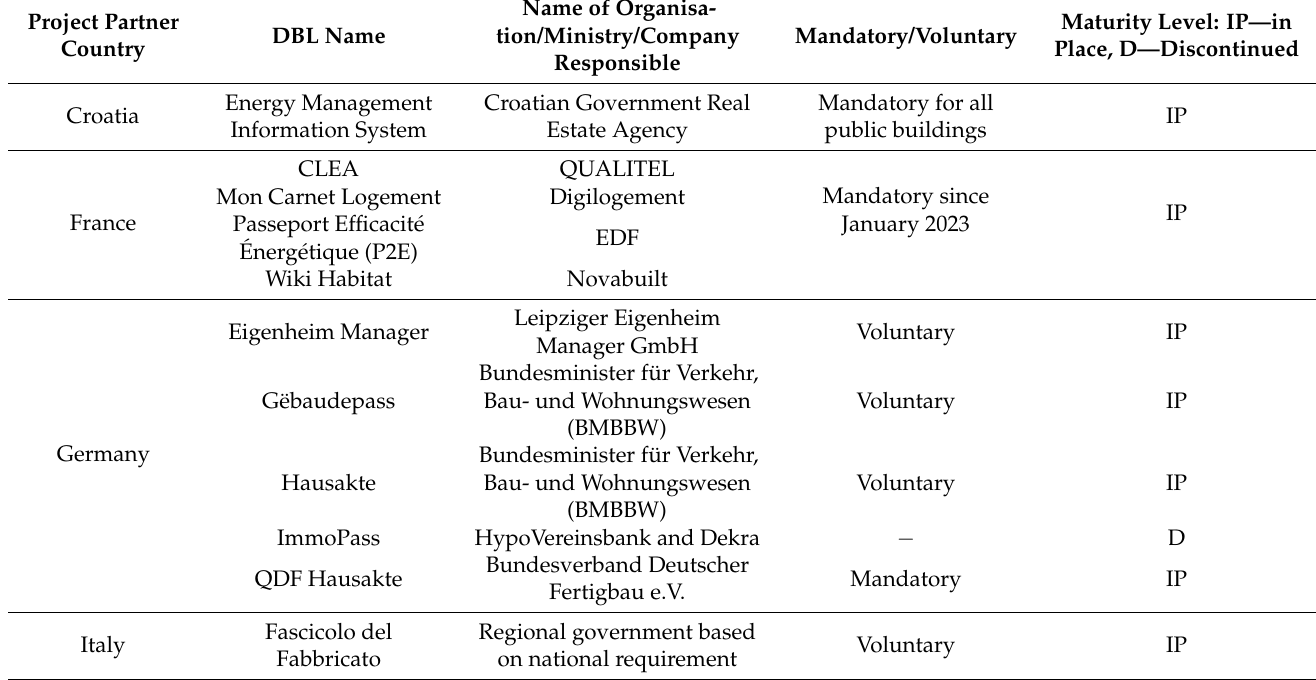
Table 3. Overview of building logbooks and initiatives across project partner countries involved in the EUB SuperHub